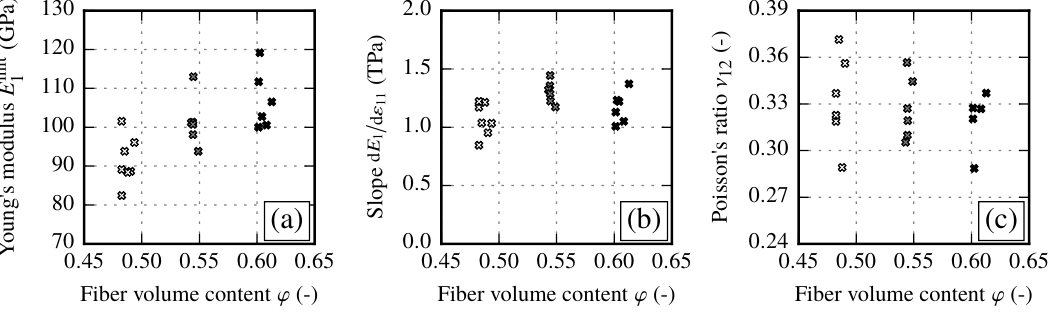
Figure 6. Reference samples—material parameters in fiber direction vs. the fiber volume content: static modulus E init ( a ), the constant slope d E 1 / d ε 11 to determine the resulting modulus E 1 at arbitrary ε 11 1 values ( b ) and the Poisson's ratio ν 12 ( c ).